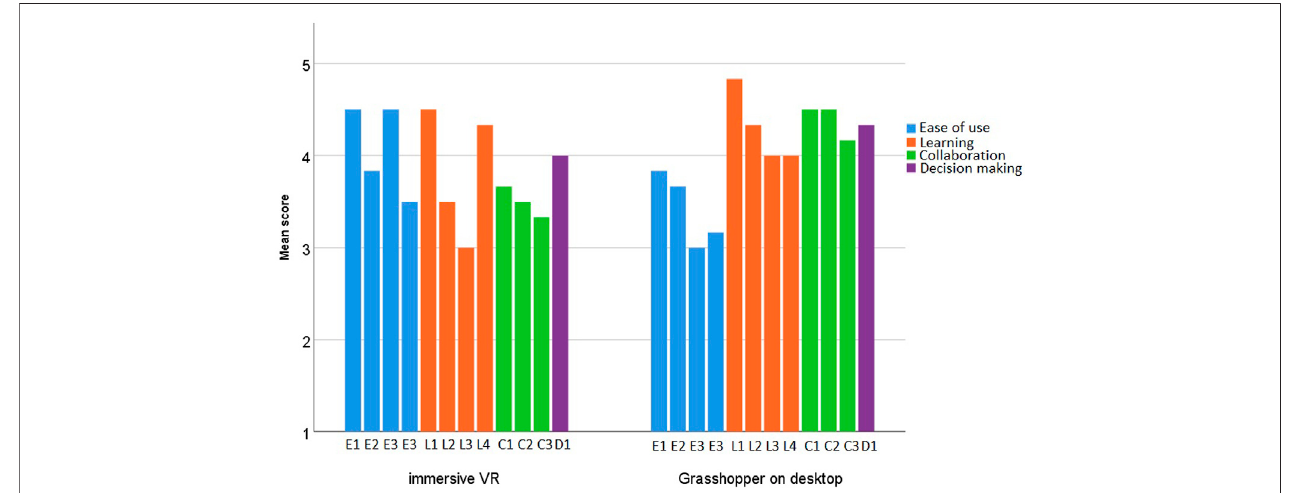
FIGURE 12 | Bar charts of questionnaire scores. The letter codes correspond to question codes in Table 1 .